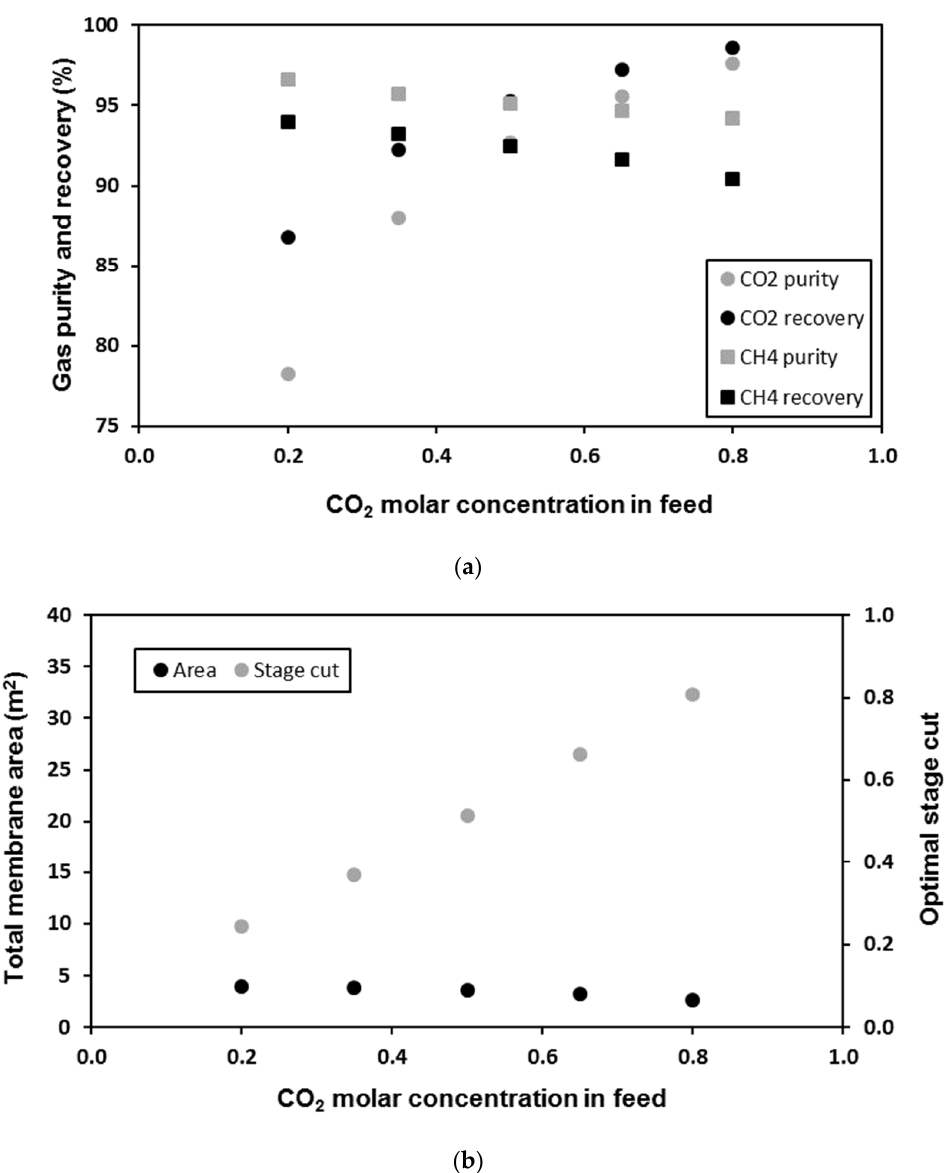
Figure 8. Influence of the feed CO 2 molar fraction on the optimal ( a ) recovery and purity and ( b ) stage cut and membrane area for the IL2 membrane.